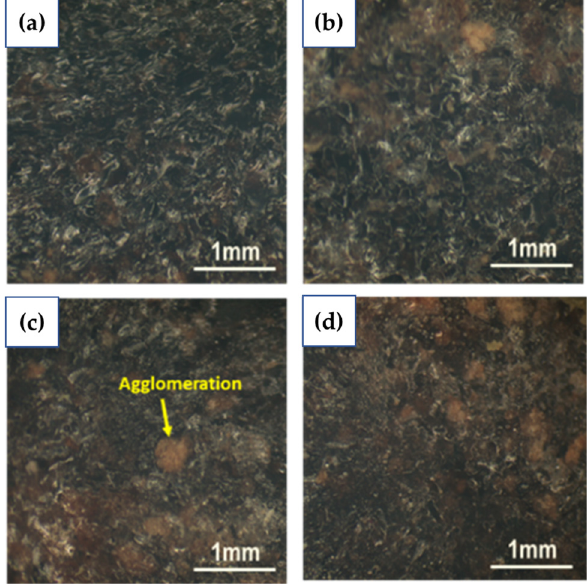
Figure 9. Microscopic of tensile-fractured TPKCF composites; ( a ) TPKCF501, ( b ) TPKCF524, ( c ) TPKCF1001, ( d ) TPKCF1024.